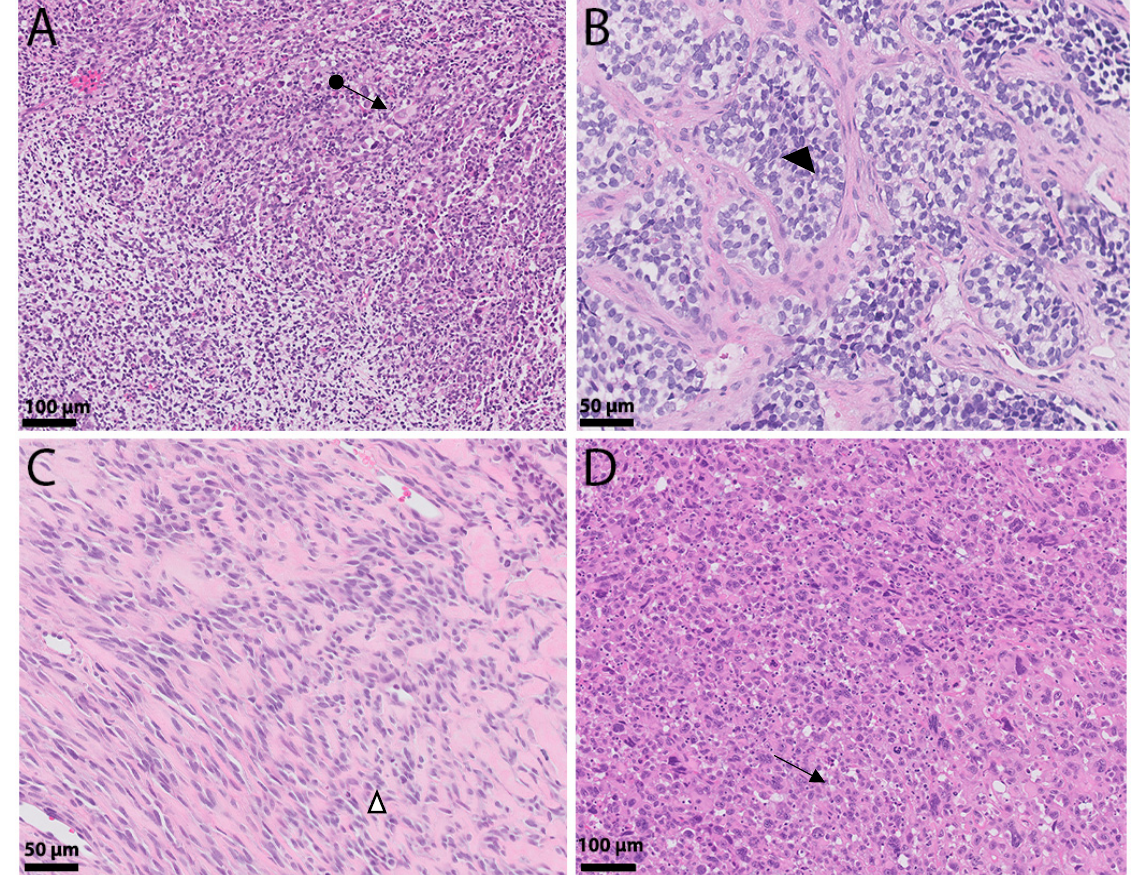
Figure 1. Histologic landscape of rhabdomyosarcoma. ( A ) Embryonal rhabdomyosarcoma composed of primitive round and spindled cells reminiscent of skeletal muscle cells ( ← ● ). ( B ) Alveolar rhabdomyosarcoma: Nests composed of hyperchromatic round cells intervened by fibrous septae, giving it an alveolar ( ◄ ) appearance. ( C ) Spindle/sclerosing rhabdomyosarcoma shows tumor cells arranged in cords ( ∆ ) that are set in a densely hyalinized eosinophilic background stroma. ( D ) Pleomorphic rhabdomyosarcoma presents with epithelioid tumors exhibiting significant nuclear pleomorphism with occasional cross striations and multinucleated cells ( ← ).